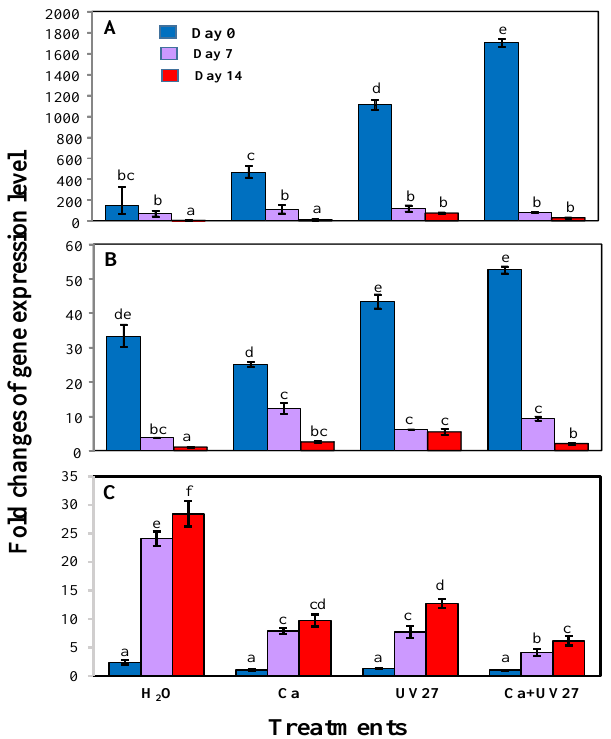
Figure 4. Expression patterns of glucosinolate structural genes CYP79F1 ( A ), MAM ( B ) and MY ( C ) during postharvest storage. Ca: 10 mM CaCl 2 ; UV27: 0.27Wh/m 2 UVB. Total RNA was extracted from microgreens on Day 0 (harvest day), Day 7, and Day 14. ACTIN was used as the internal control. Error bars represent standard error of the mean. Different letters indicate significant differences among mean values ( p < 0.05; t -test). Data presented are the means of three